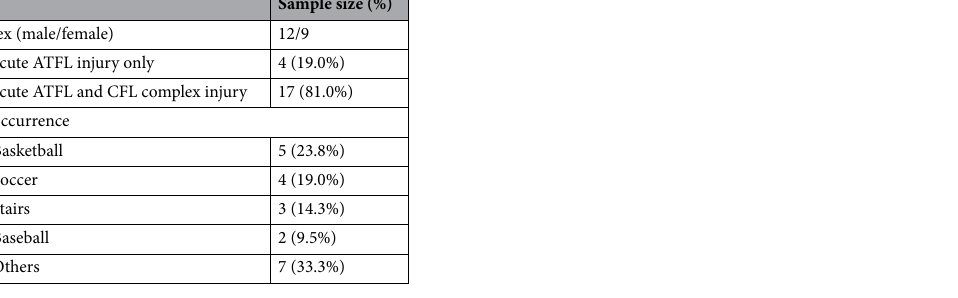
Table 1. Demographic data of participants. ATFL anterior talofibular ligament, CFL calcaneofibular